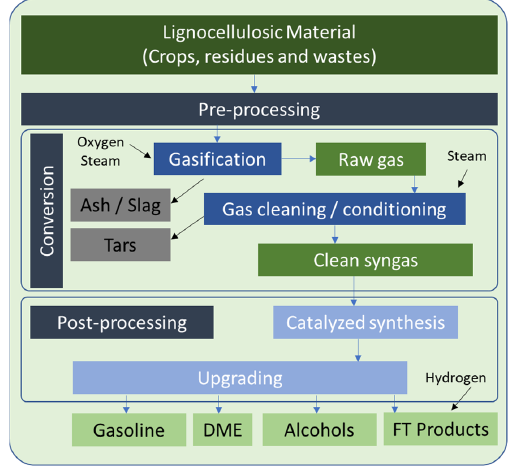
Figure 10. PVC1–BtL via gasification. Adapted from [26].